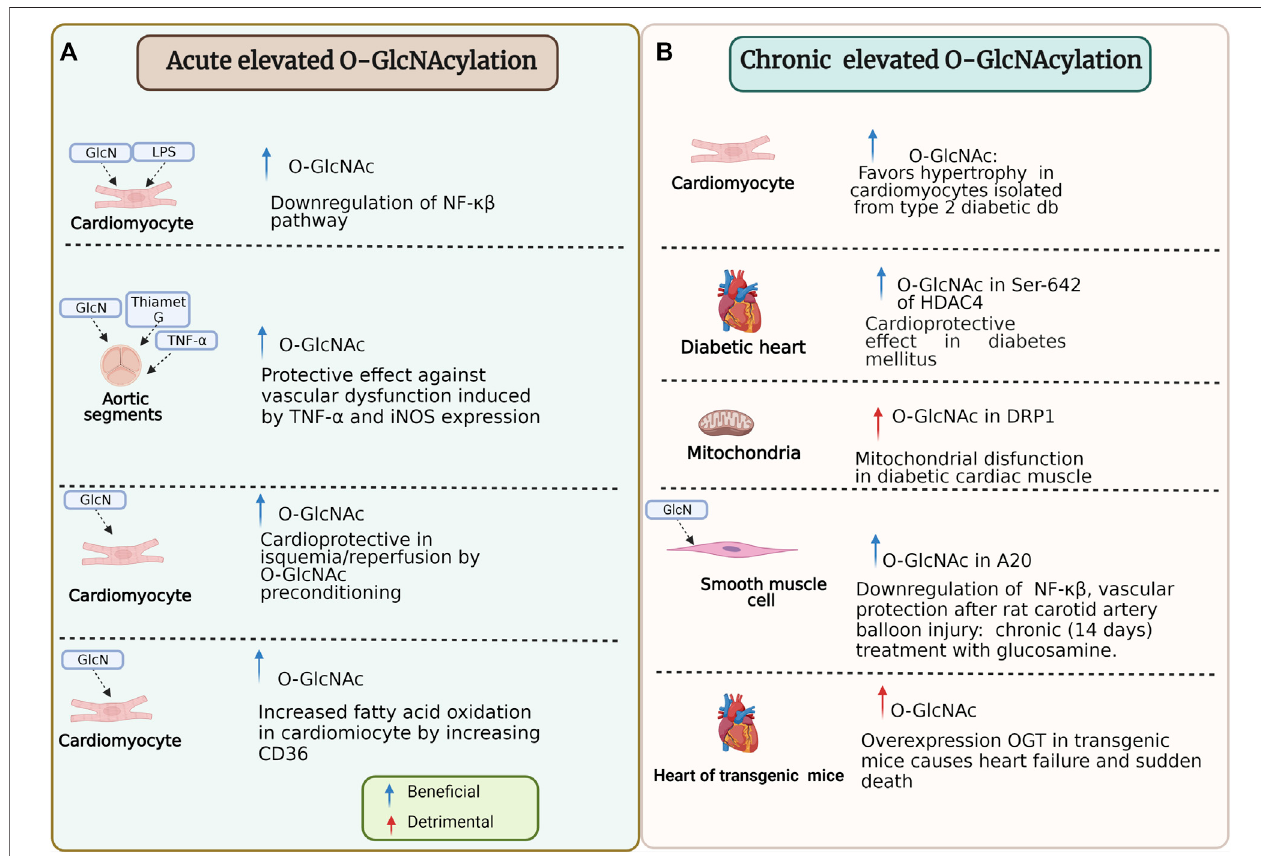
FIGURE 5 | Bene fi cial and detrimental effects of O-GlcNAcylation due to the timing of the modi fi cation and speci fi c stimulus. (A) Some experiments that re fl ect effects under speci fi c conditions of acute elevated O-GlcNAcylation on cardiomyocyte and aortic segments. (B) Some experiments that re fl ect effects under speci fi c conditions of chronic elevated O-GlcNAcylation on cardiomyocyte, mitochondria, smooth muscle cell, and heart function. HDAC4, histone deacetylase 4; NF- κβ /p65, nuclear transcription factor kappa-beta-p65; LPS, lipopolysaccharide; GlcN, Glucosamine; OGT, O-linked N-Acetylglucosamine transferase; TNF- α , tumor necrosis factor- α ; iNOS, inducible nitric oxide synthase; O-GlcNAc, O-linked β -N-acetylglucosamine; DRP1, dynamin-related protein 1; A20, also known as TNFAIP3 tumor necrosis factor α -induced protein 3. For more detail see the